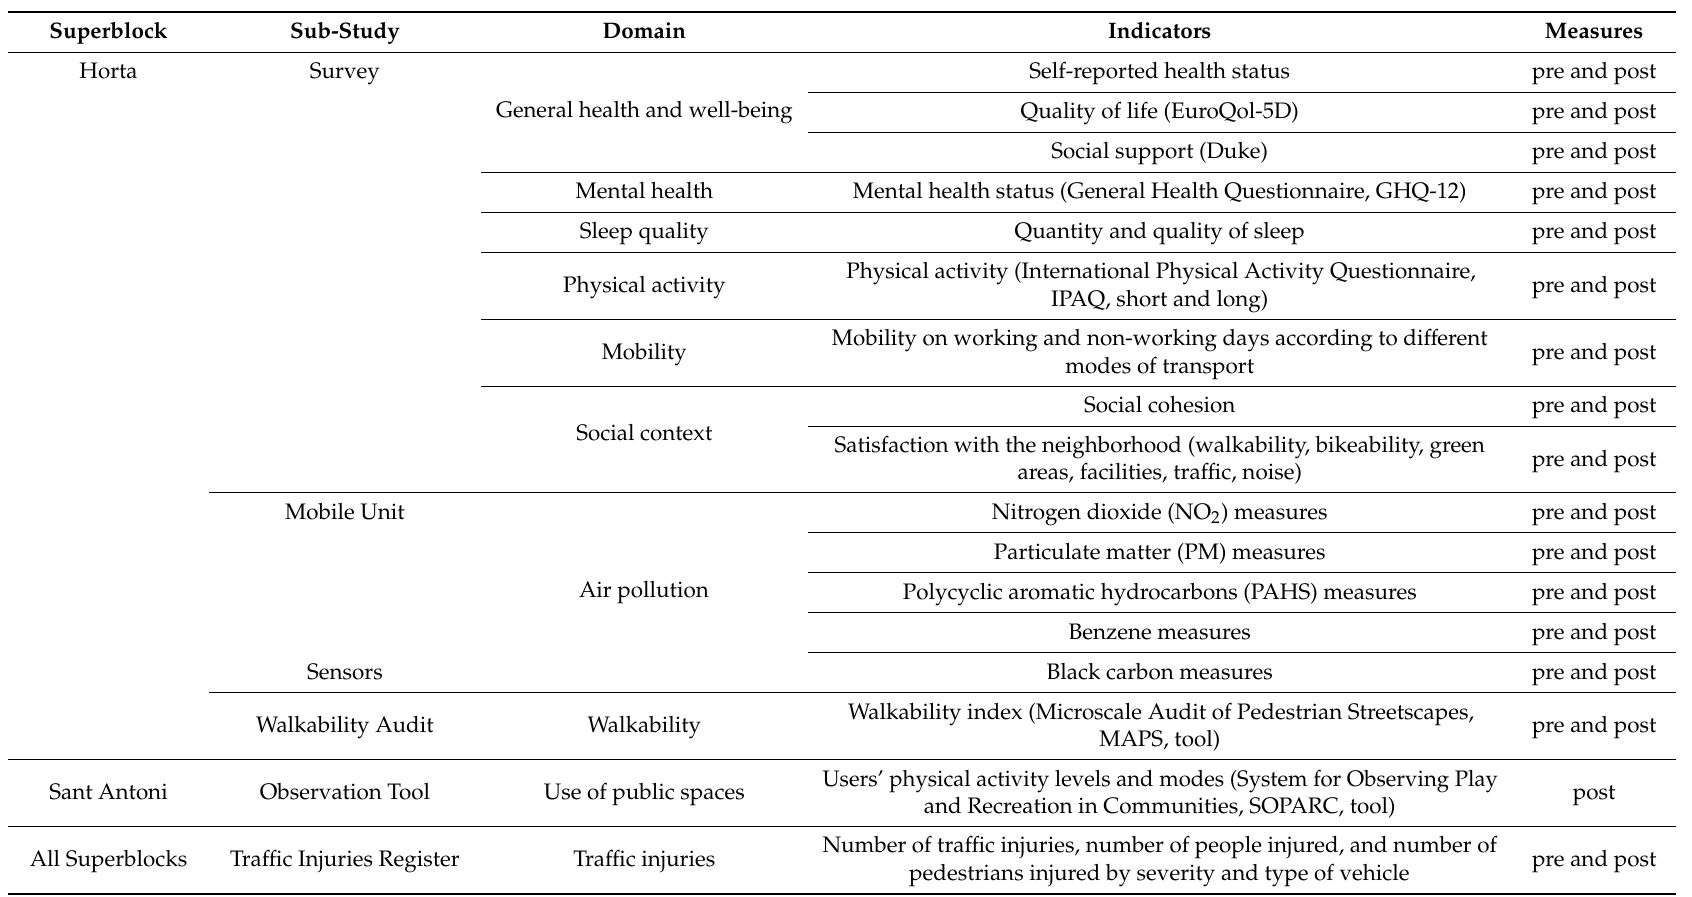
Table 1. Superblock studied, objectives answered, indicators measured, and sources used in each Quantitative study of the Salut Als Carrers (SAC)